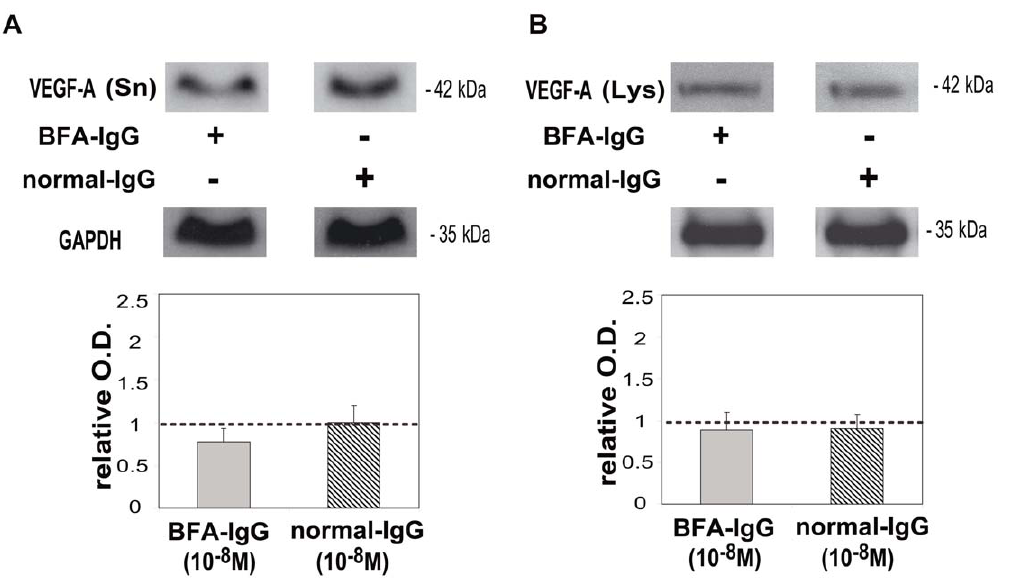
Figure 3. Effect of BFA-IgG and normal IgG on VEGF-A expression in MCF-7 cells. Tumor cells were treated with 10 2 8 M benign fibroadenoma (BFA) or normal-IgG during 1 h and Western blot assays were performed in MCF-7 cell A) supernatants (Sn) and B) lysates (Lys). Densitometric analysis of the bands is shown. Values were relativized to the expression of glyceraldehyde-3-phosphate dehydrogenase (GAPDH) and to VEGF-A in MCF-7 cells without treatment considered as 1, and is represented by a dotted line. Molecular weights are indicated on the right. Values are mean 6 S.E.M. of three experiments.